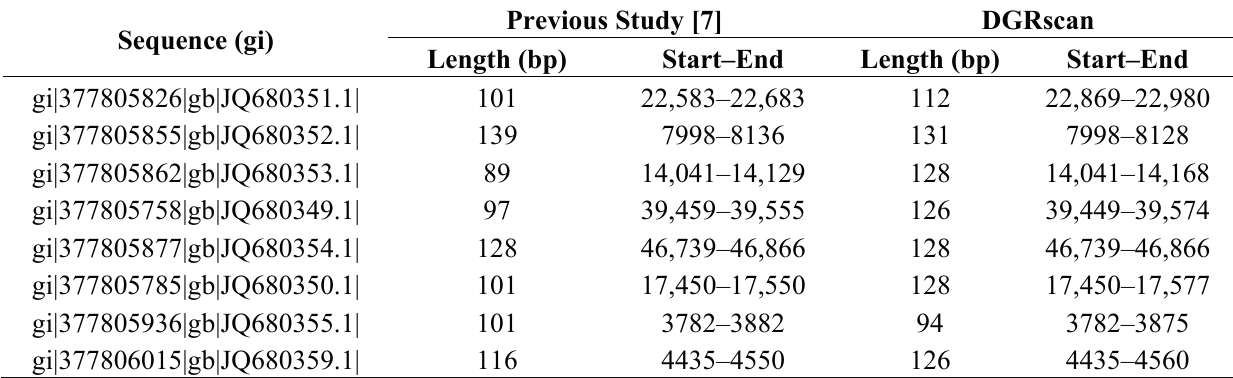
Table 1. Identification of template regions (TRs) by DGRscan for the human virome dataset. Sequence